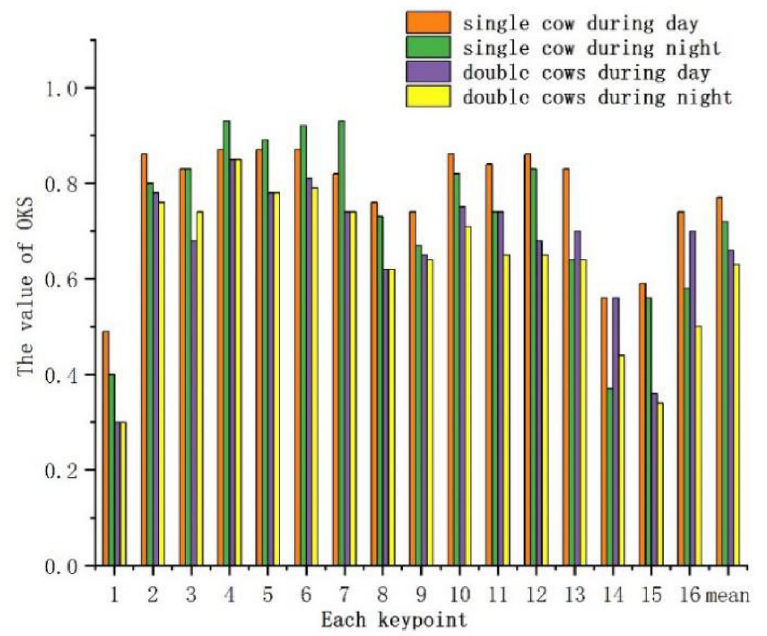
Fig 5. The confidence of various keypoints in different scenarios.